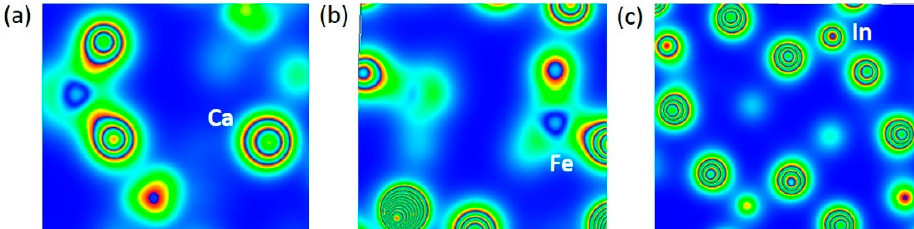
Figure 7. Charge density plots associated with the most favorable dopants: ( a ) Ca 2+ , and ( b ) Fe 3+ and ( c ) In 3+ .